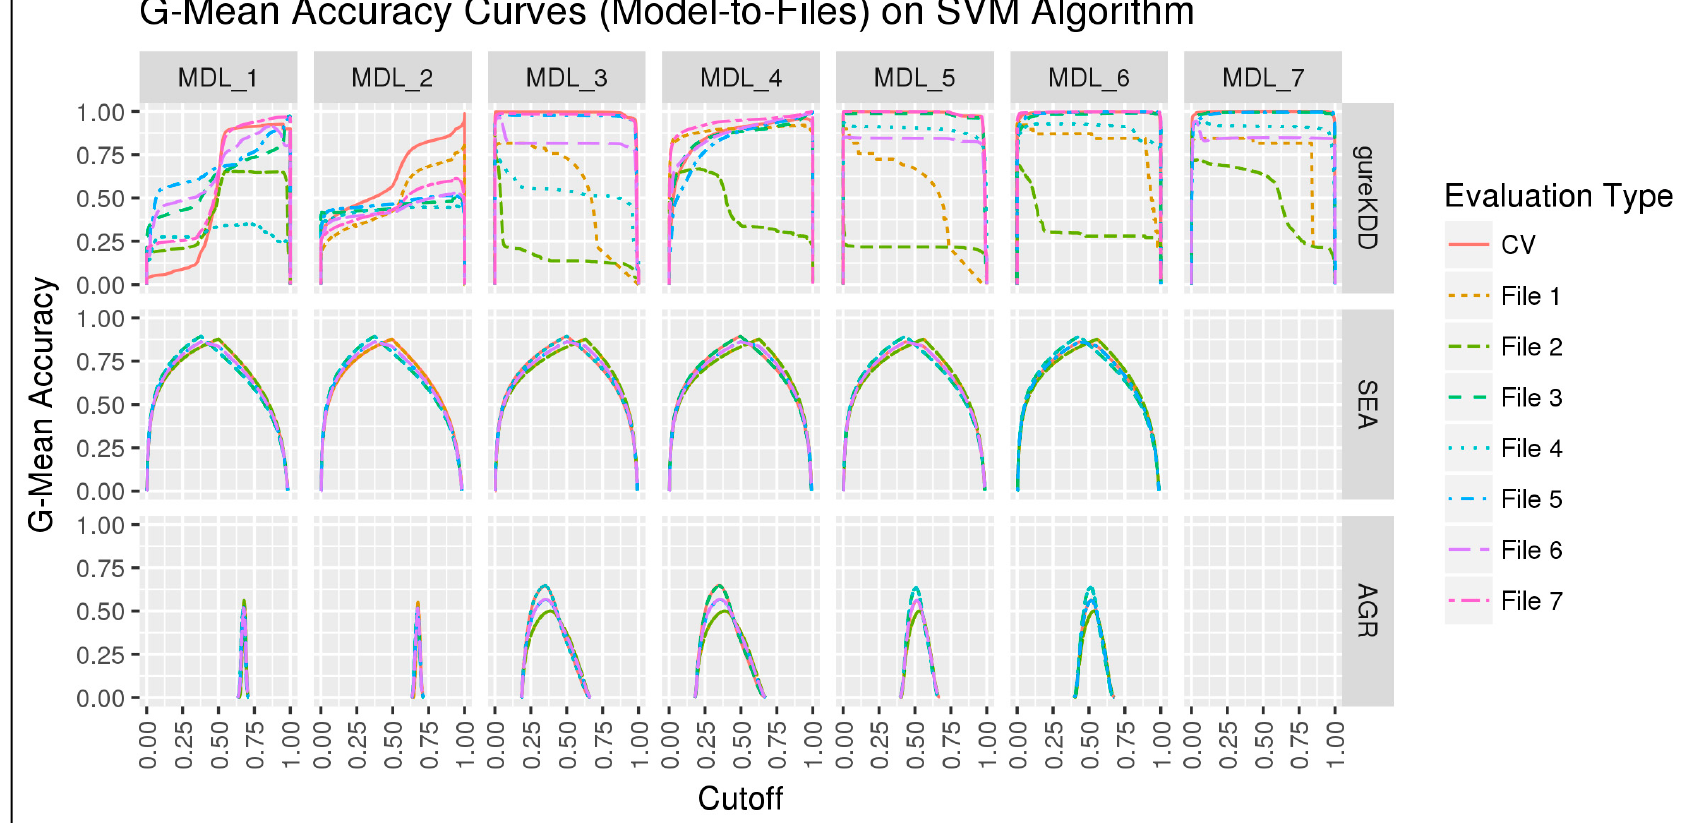
Figure A3. The gAcc curves for the SVM algorithm (see Table A3).